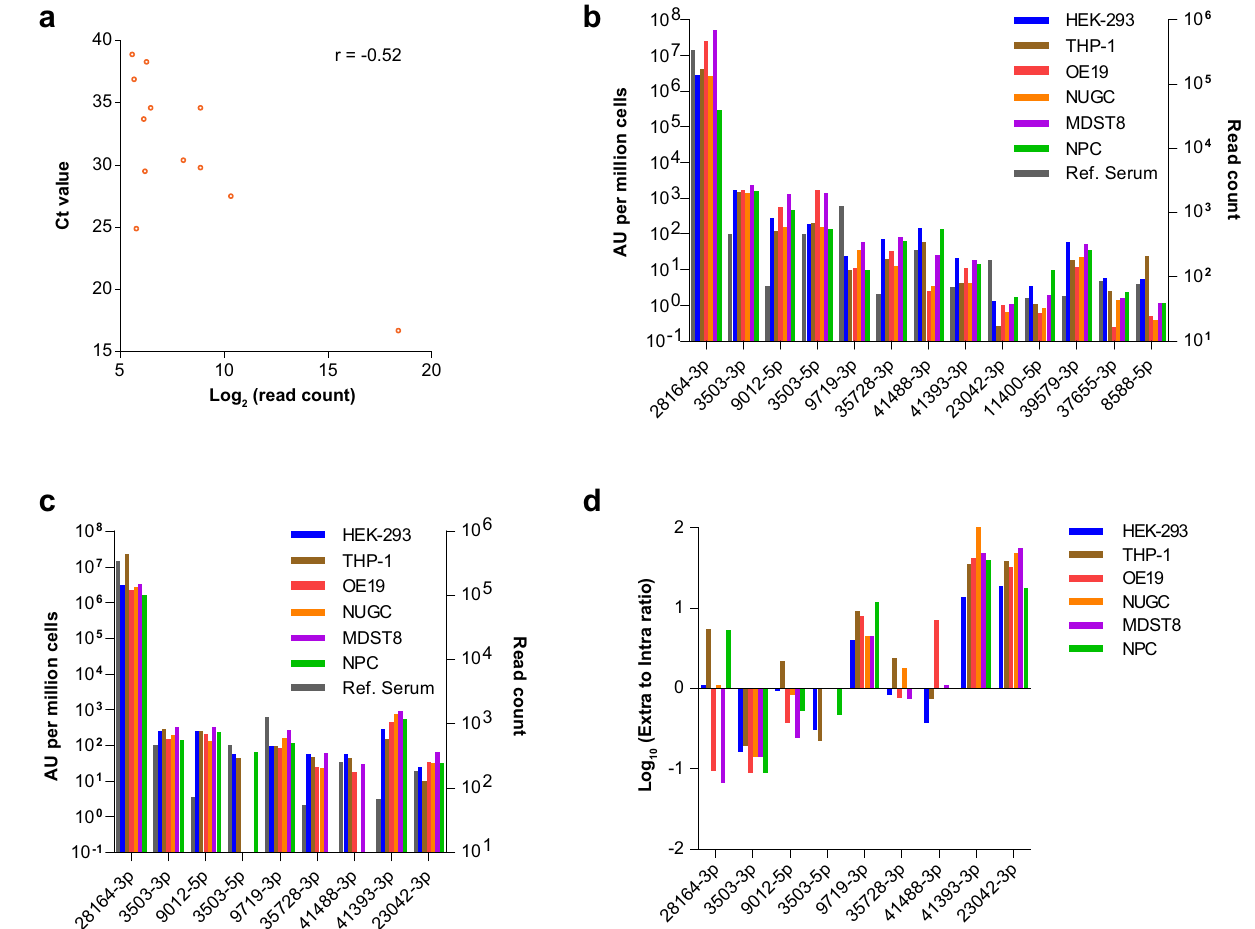
Figure 4. Validation of 14 novel miRNAs identified in Ref. Serum. ( a ) Correlation in expression levels of predicted mature miRNAs measured by qPCR and miRNA-Seq in Ref. Serum. Two miRNAs were not detected above the LOD (data points not shown). r Spearman’s correlation coefficient. ( b ) Intracellular expression levels of 13 novel miRNAs measured by qPCR across six human cell lines (left y-axis) and read count measured by miRNA-Seq in Ref. Serum (right y-axis). One miRNA was not detected above LOD (data points not shown). ( c ) Extracellular expression levels of nine novel miRNAs measured by qPCR across six human cell lines (left y-axis) and read count measured by miRNA-Seq in Ref. Serum (right y-axis). Five miRNAs were not detected above LOD (data points not shown). ( d ) Ratio of extracellular to intracellular